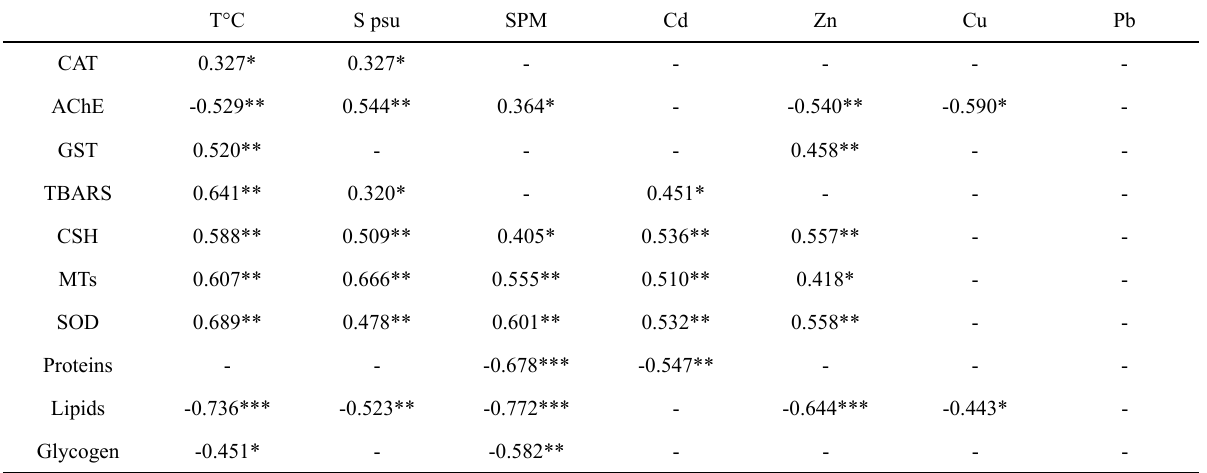
4. – The matrix of correlation between the analysed parameters and the sampled P.